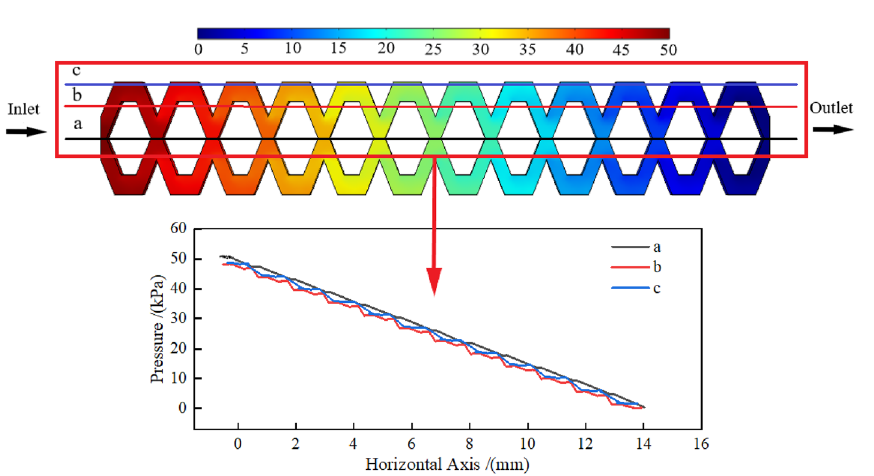
Figure 9. The pressure distribution in the pit flow